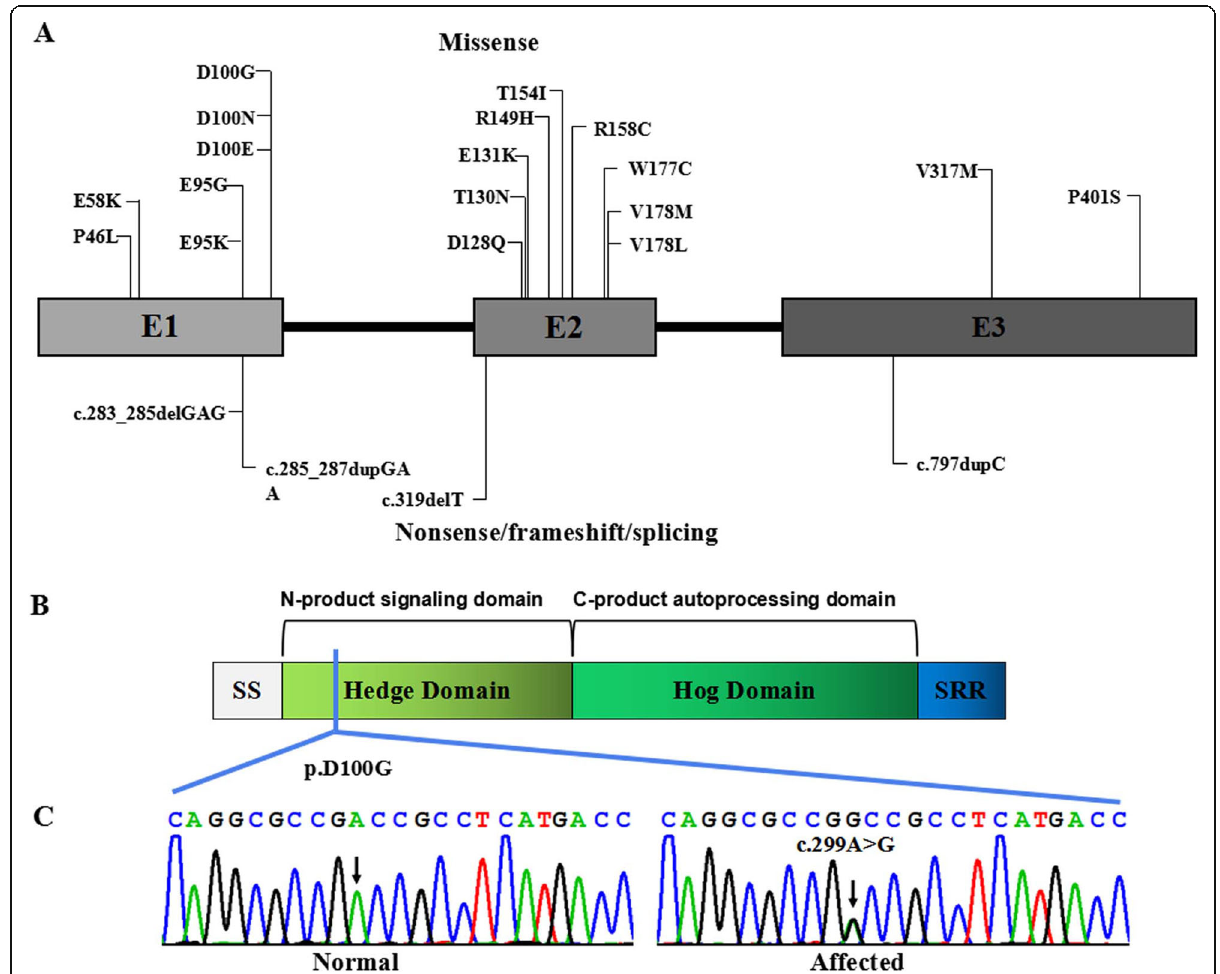
Fig. 4 IHH pathogenic variants. a Boxes represent three different exons as indicated, and solid lines connecting these boxes represent the introns of IHH gene. The numbers above the boxes indicate the positions of the IHH complementary DNA at the start – stop sites and exon – intron boundaries. Vertical lines represent the locations of missense (above the boxes) or nonsense/frameshift/splicing (below the boxes) variants. b IHH protein structure with key domains, regions, and the mutation indicated. c Sanger sequencing chromatograms showing a missense variant c.299A > G(p.Asp100Gly) in the affected individuals in comparison to those of unaffected